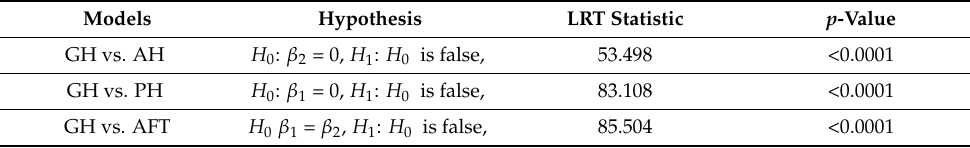
Table 6. LRT values for the GH model and its sub-models using IPASS dataset.